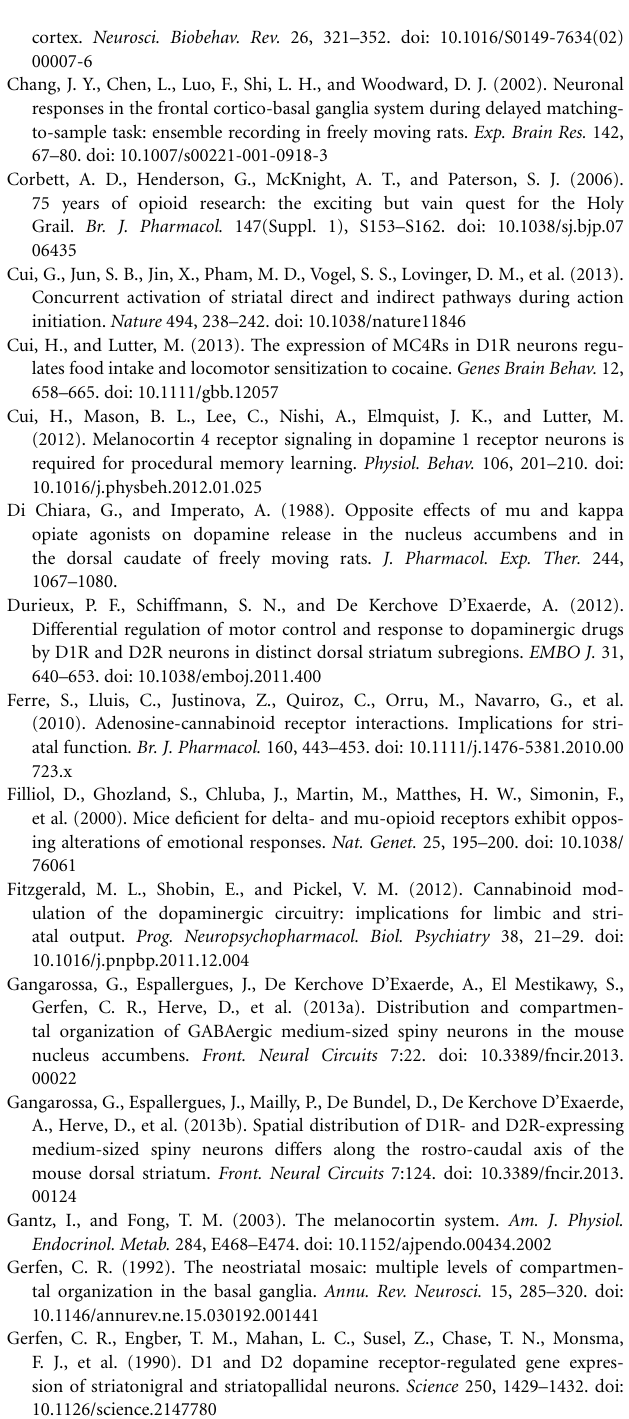
FIGURE 4 | Continued represent the mean percentage ( + s.e.m.) of DAPI stained nuclei that are positive for DRD1, DRD2, MOR, DOR, or KOR , where “&” indicates a significant difference of p < 0 . 05 in the mean percentage of DRD1 positive cells compared to DRD2 positive cells (as determined by the Mann–Whitney U test). (H,J,L) Quantification of coexpression of DRD1 or DRD2 and MOR, DOR, or KOR . Bars represent the mean percentage ( + s.e.m.) of cells